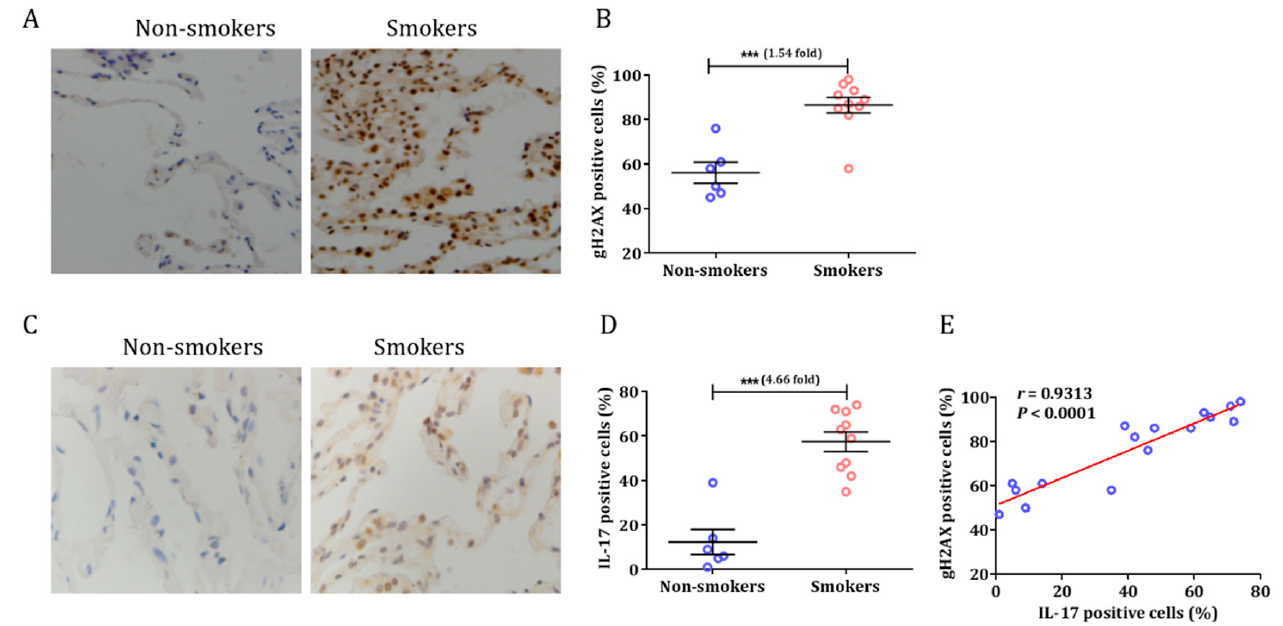
Figure 1. Cigarette smoke induced DDR and airway inflammation in human samples. ( A ) Representative examples of immunohistochemistry of gH2AX expression in the lungs of human specimens. ( B ) Percentages of cells expressing gH2AX in smokers and non-smokers. ( C ) Representative examples of immunohistochemistry of IL-17 expression in human lung tissue. ( D ) Percentages of cells expressing IL-17 in smokers and non-smokers. ( E ) The relationship between IL-17 expression and DDR in lung specimens. (n = 6 mice per group in each experiment. Image magnification of immunohistochemistry: 10 × 100. Data are presented as means ± SEM, *** p < 0.001).